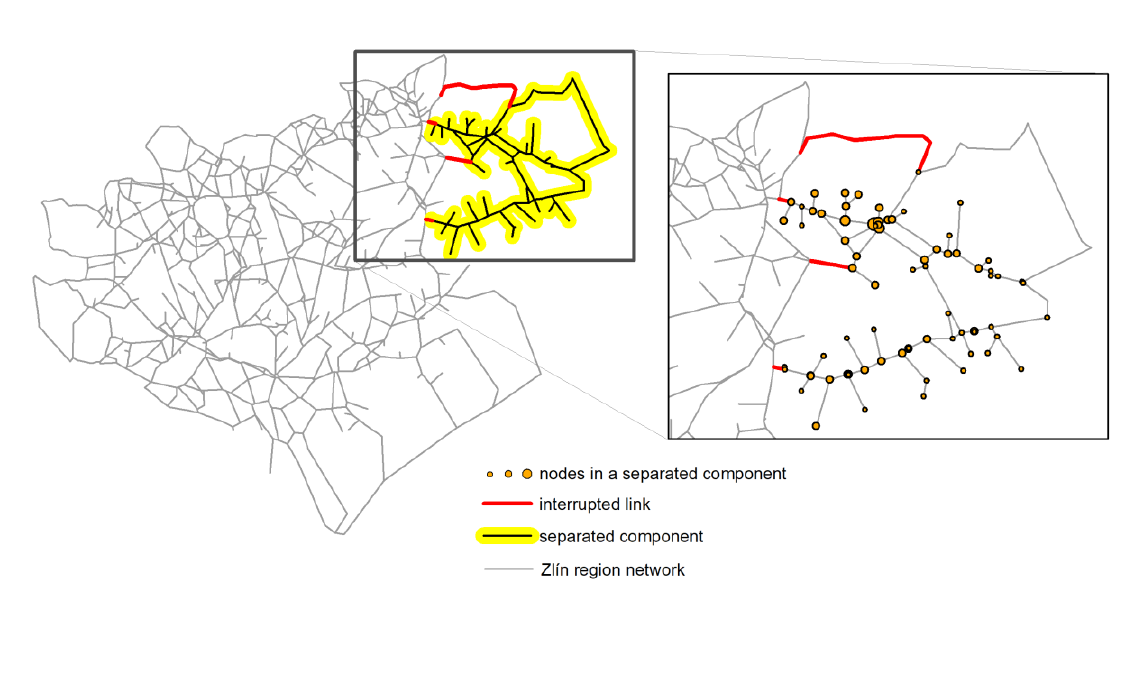
The worst scenario found by ANSA for 4four concurrently interrupted road links in the Zlín region network. 56,707 people (9.65%) cut off from the main